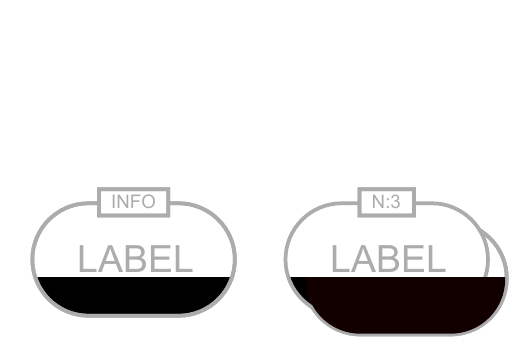
Figure 2.5: The Process Description glyph for simple clone marker applied to a simple chemical and a multimer of simple chemicals .